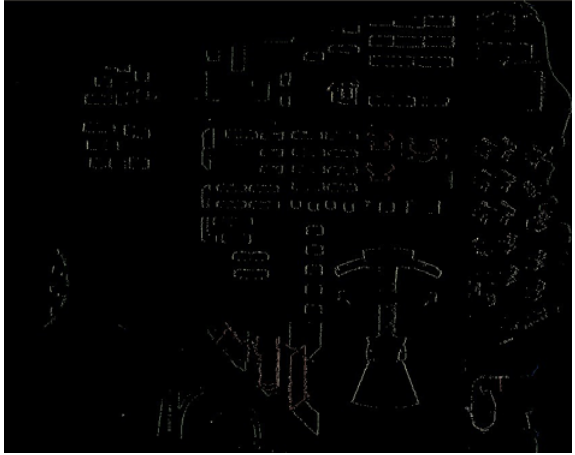
Figure 8 ． Man-made structure edge extraction results based on PWD